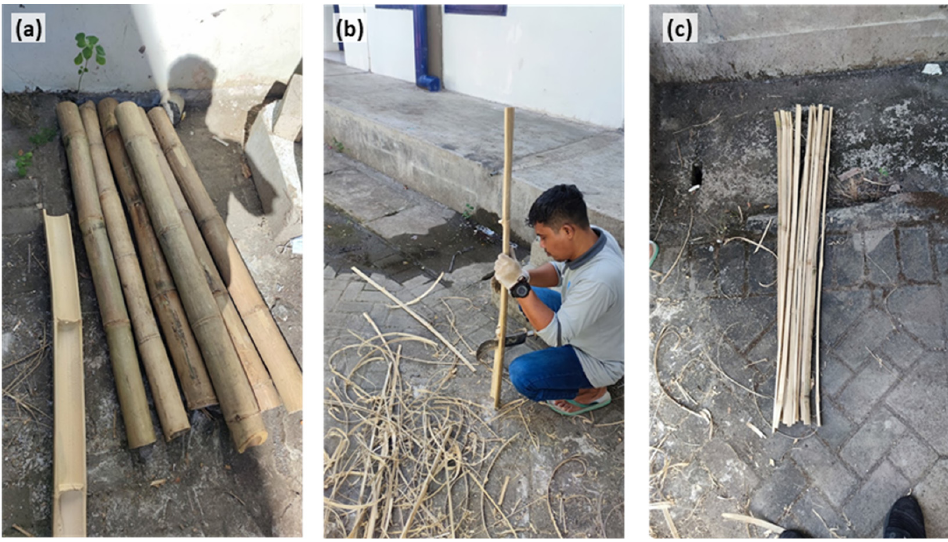
Figure 4. Preparation of bamboo strips for masonry retrofitting: ( a ) bamboo rods cut from the tree, ( b ) slicing the bamboo into strips, ( c ) bamboo strips used for retrofitting. A uniaxial tensile test was performed to evaluate the tensile strength of the bamboo under study. The dimensions of the bamboo specimen and the tensile test method are shown in Figures 5 and 6, respectively.